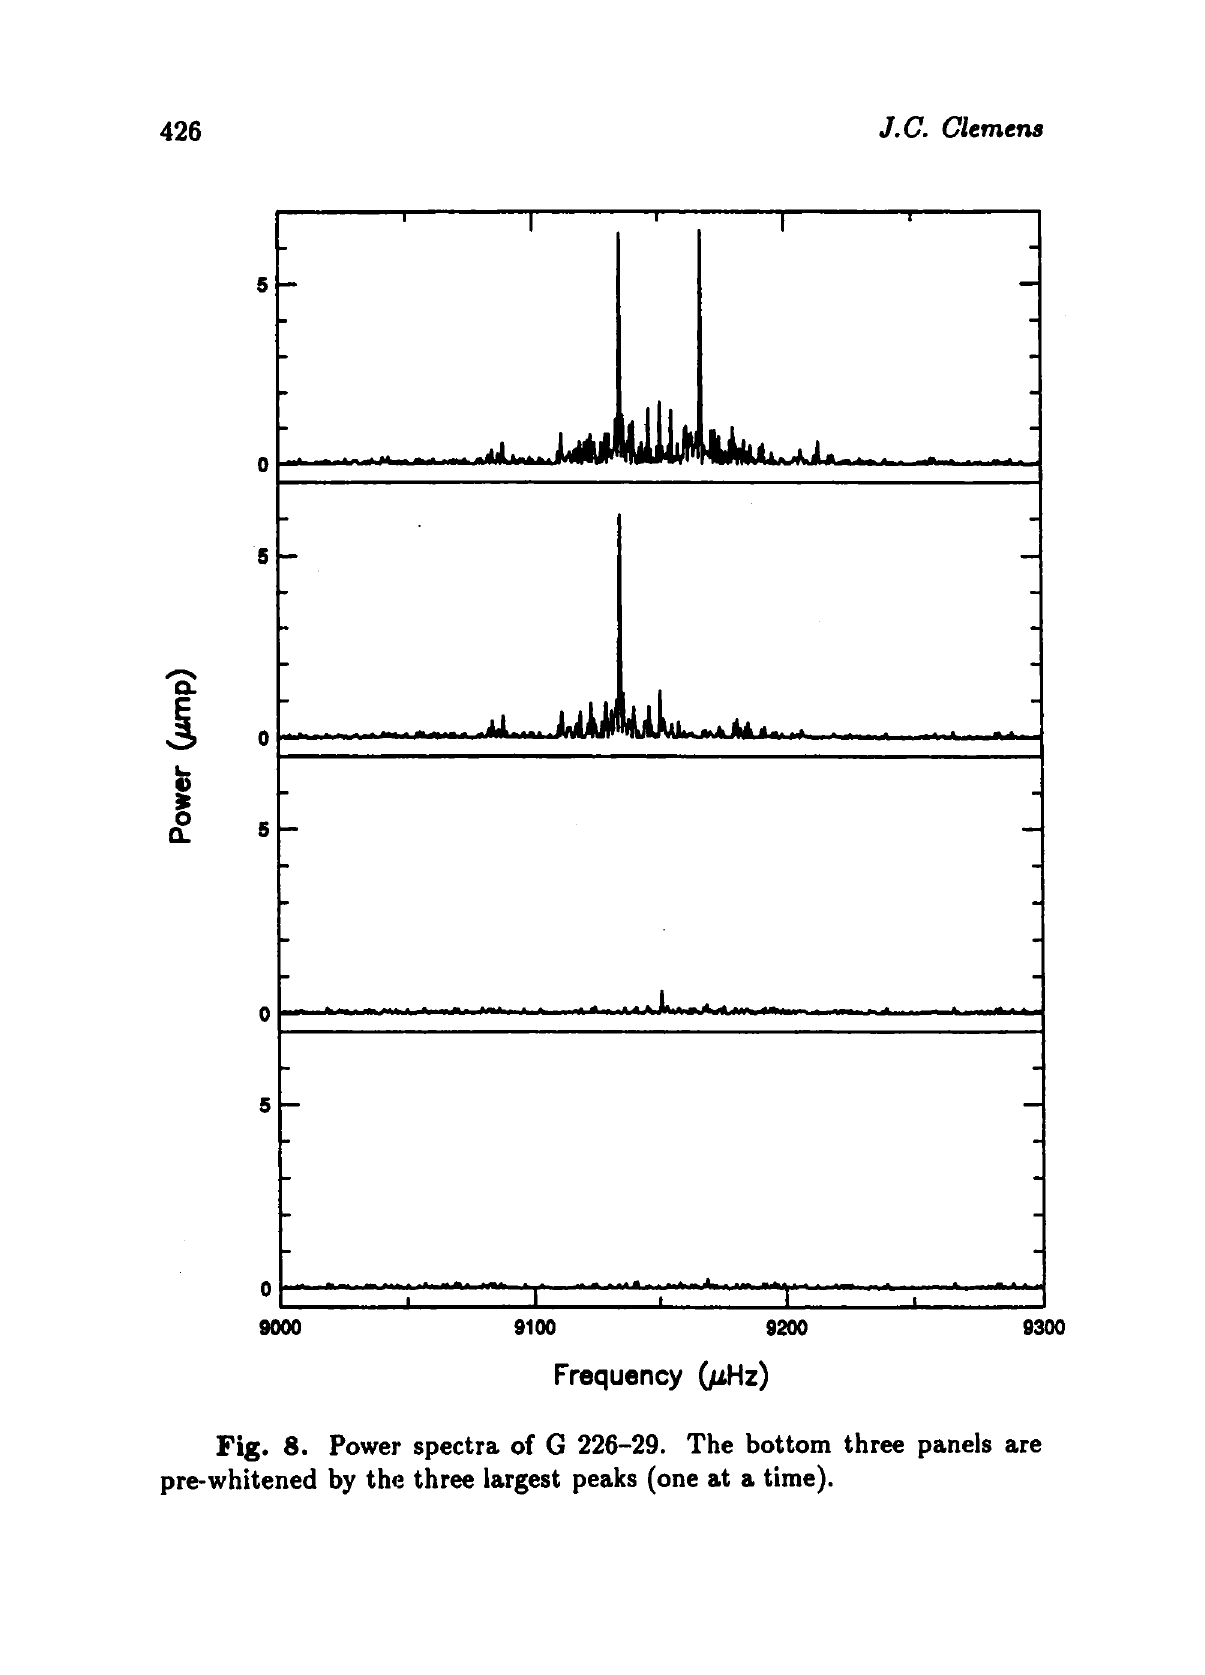
Fig. 8. Power spectra of G 226-29. The bottom three panels are pre-whitened by the three largest peaks (one at a